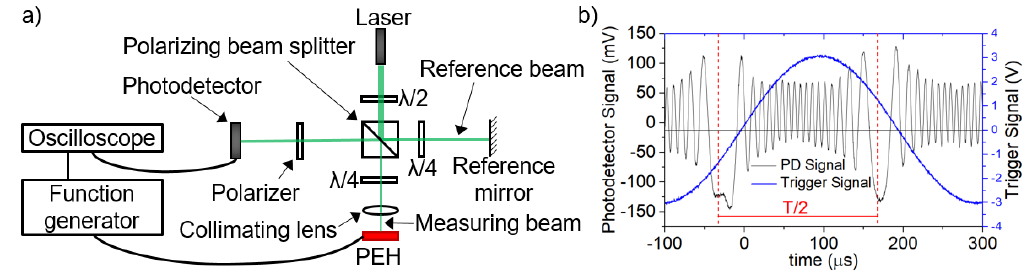
Figure 7. Interferometric measurement: ( a ) setup; ( b ) oscilloscope electrical signal.